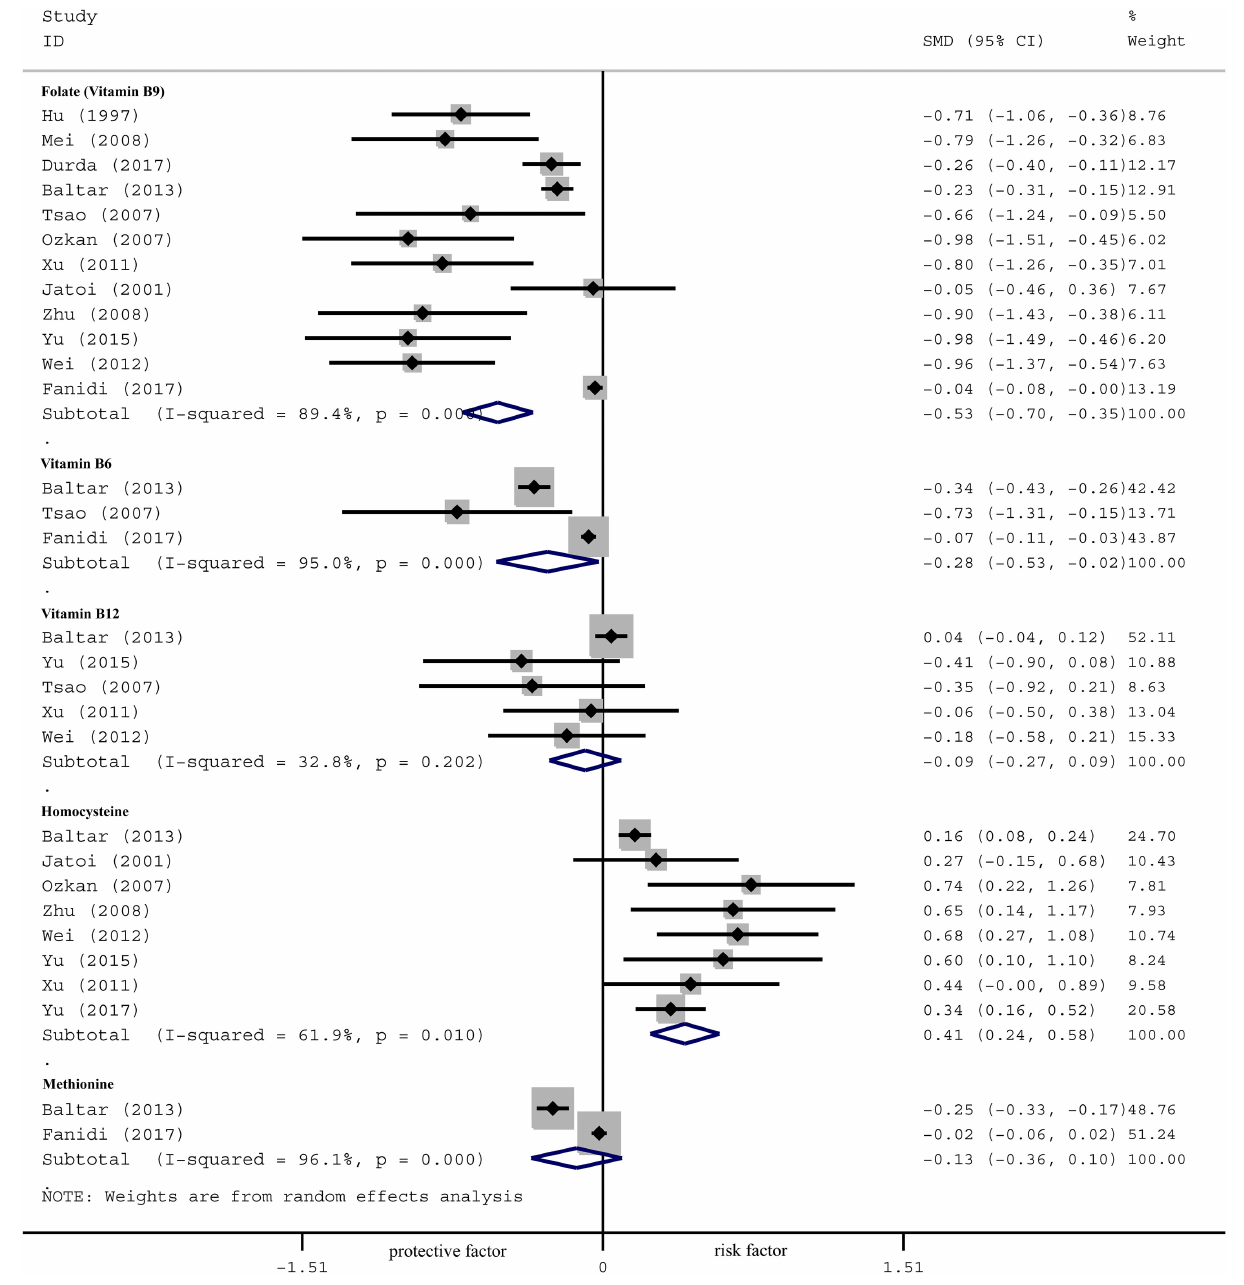
According to the quality evaluation criteria, these 14 studies scored from 4 to 9, and Eight of them were high-scoring studies (quality score ≥ 6).